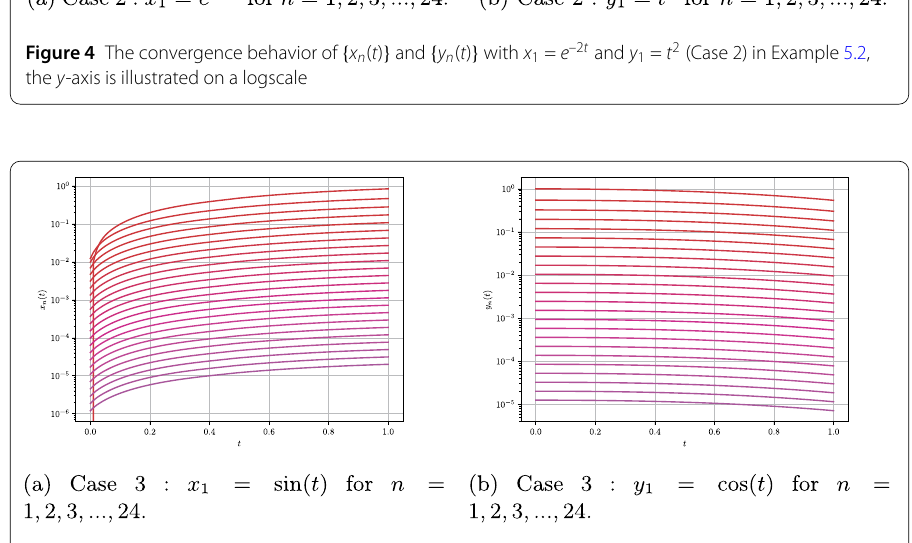
Figure 5 The convergence behavior of { x n ( t ) } and { y n ( t ) } with x 1 = sin( t ) and y 1 = cos( t ) (Case 3) in Example 5.2, the y -axis is illustrated on a logscale